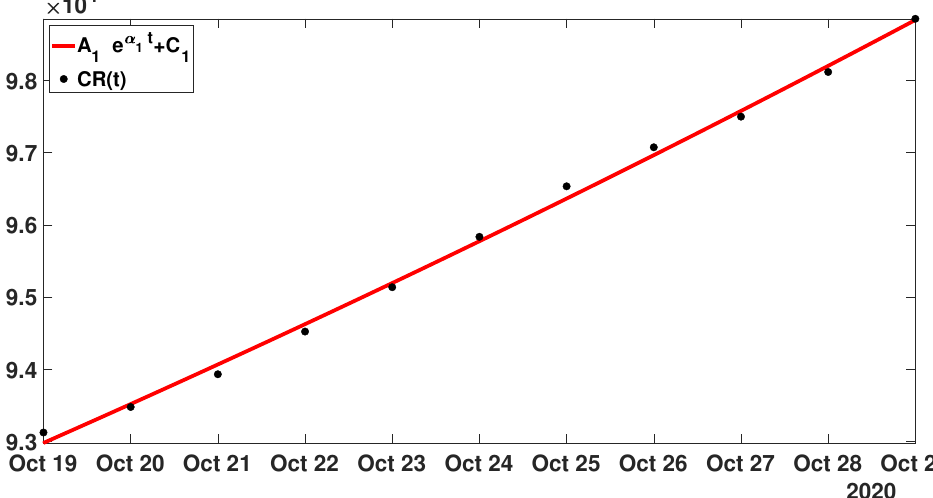
Figure 5. In this figure, the black dots correspond to the cumulative numbers of reported cases of COVID-19 in Japan between 19 October and 29 October 2020 (black dots). The red curve corresponds to the best fit of model (15) to the cumulative numbers of reported